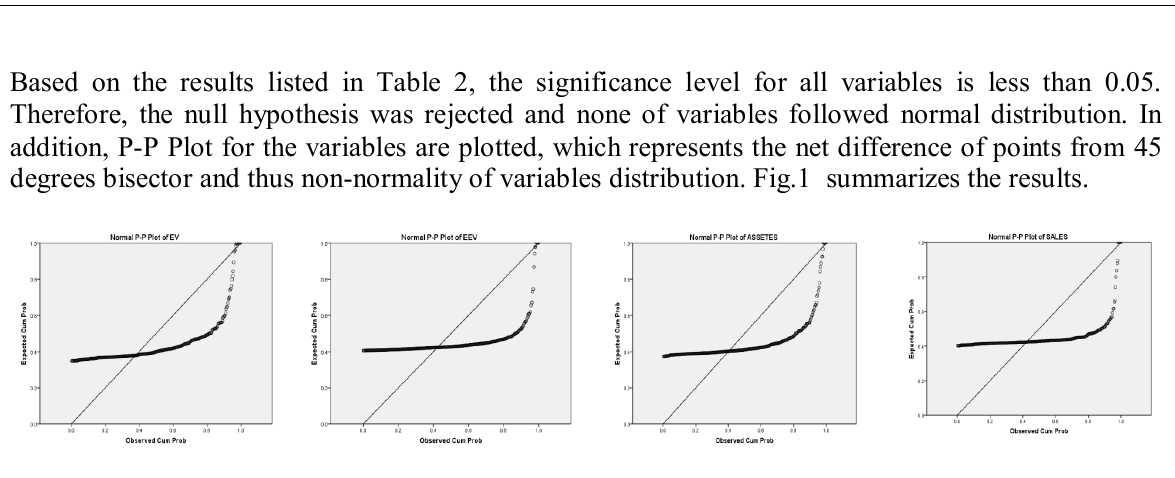
Fig. 1. The results of observed cumulative